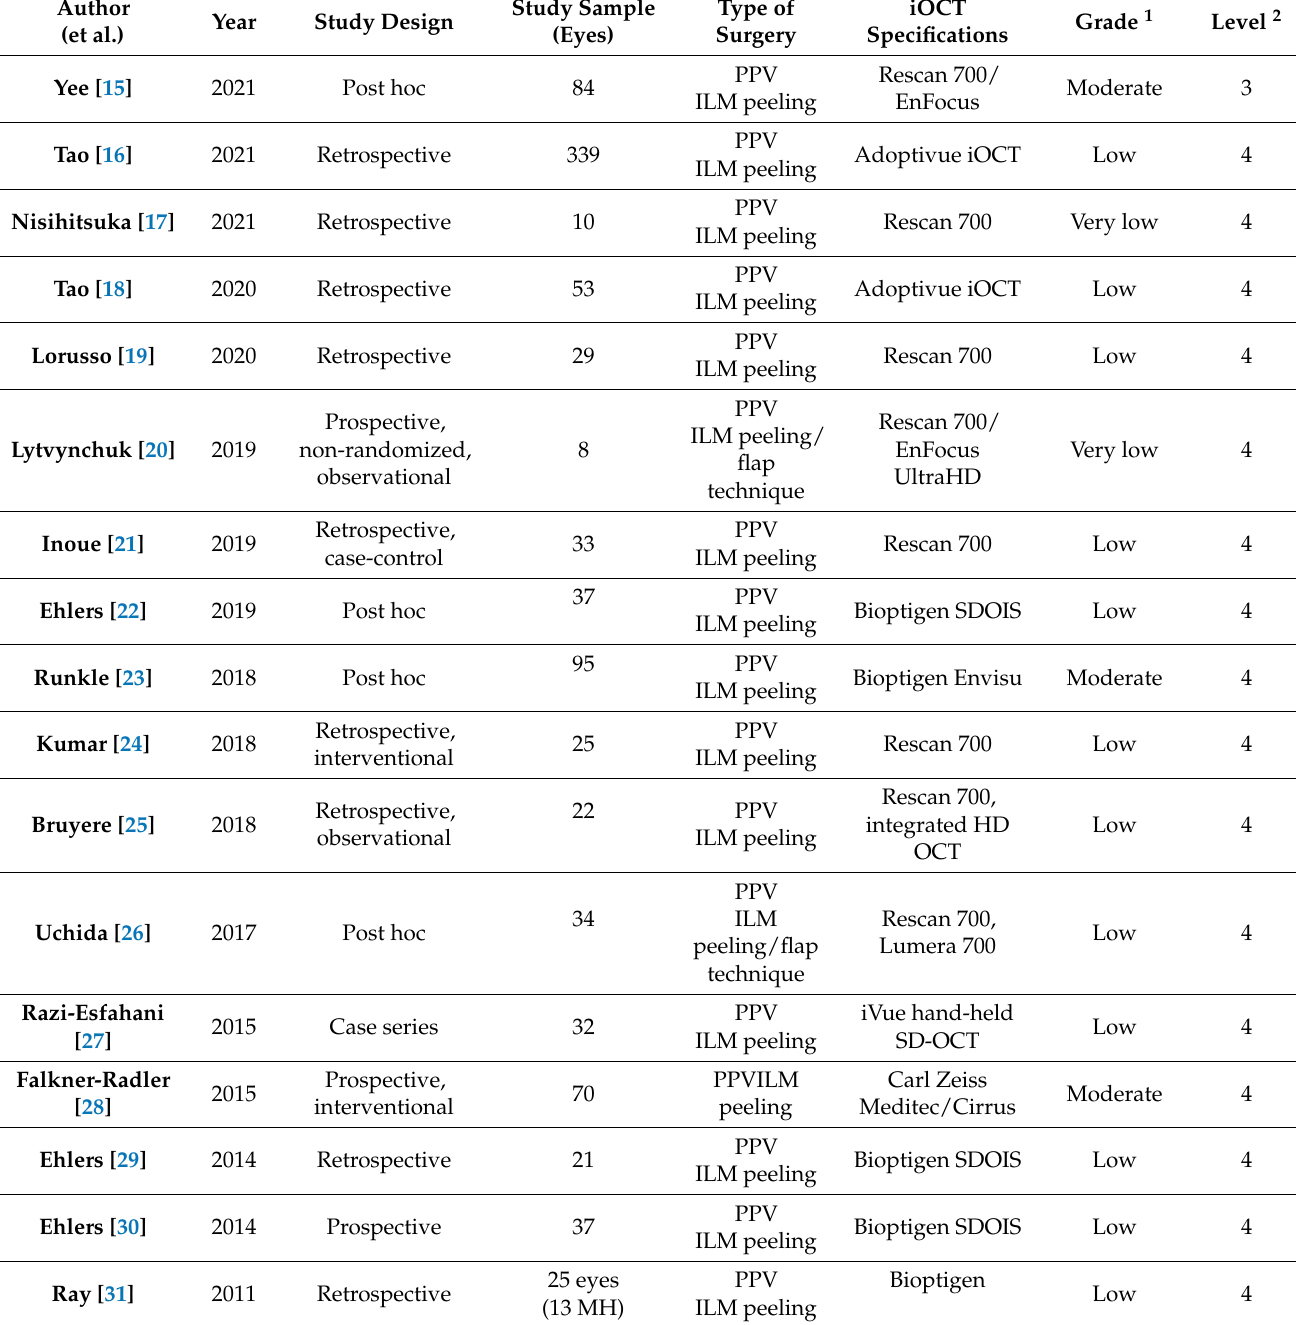
Table 1. Characteristics, quality, and level of evidence of the included studies and features of the iOCT cited by these